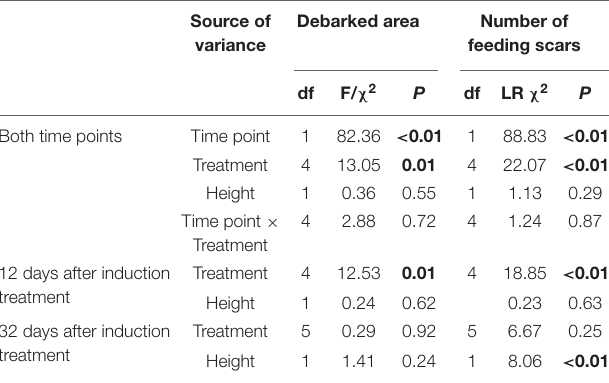
TABLE 3 | Results of analysis of deviance (df: degrees of freedom; χ 2 : Chi-square value; LR χ 2 : likelihood ratio Chi-square value; P : P -value) from several models examining the effect of treatment on subsequent pine weevil damage in experiment 2.